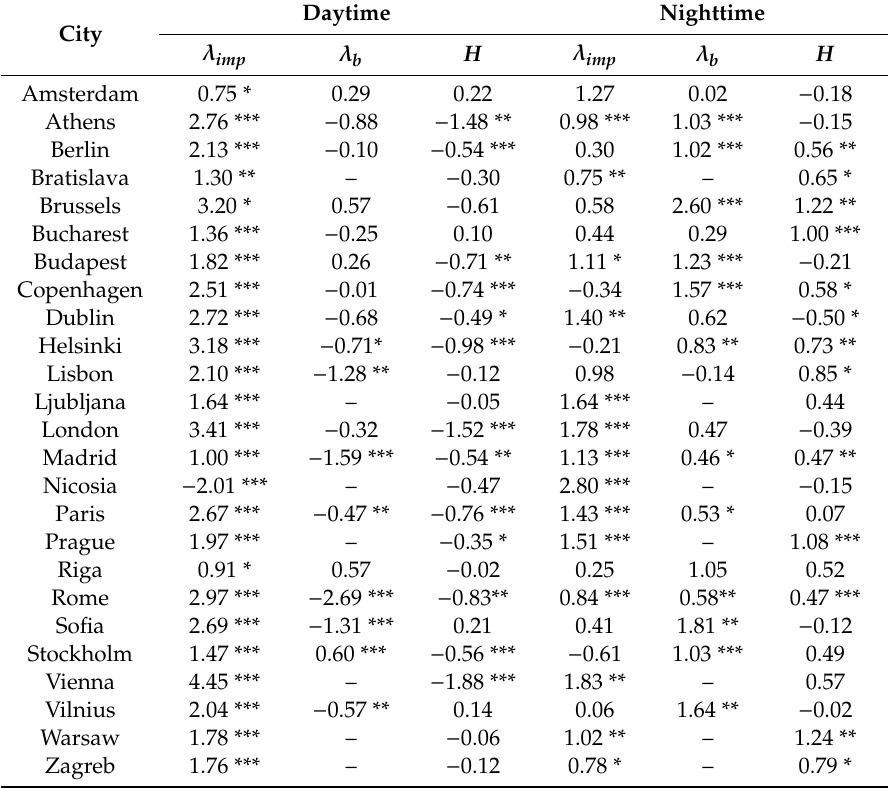
Table 8. Standardized regression coe ffi cients (total e ff ect) for the spatial regression models SLM between the urban surface parameters and